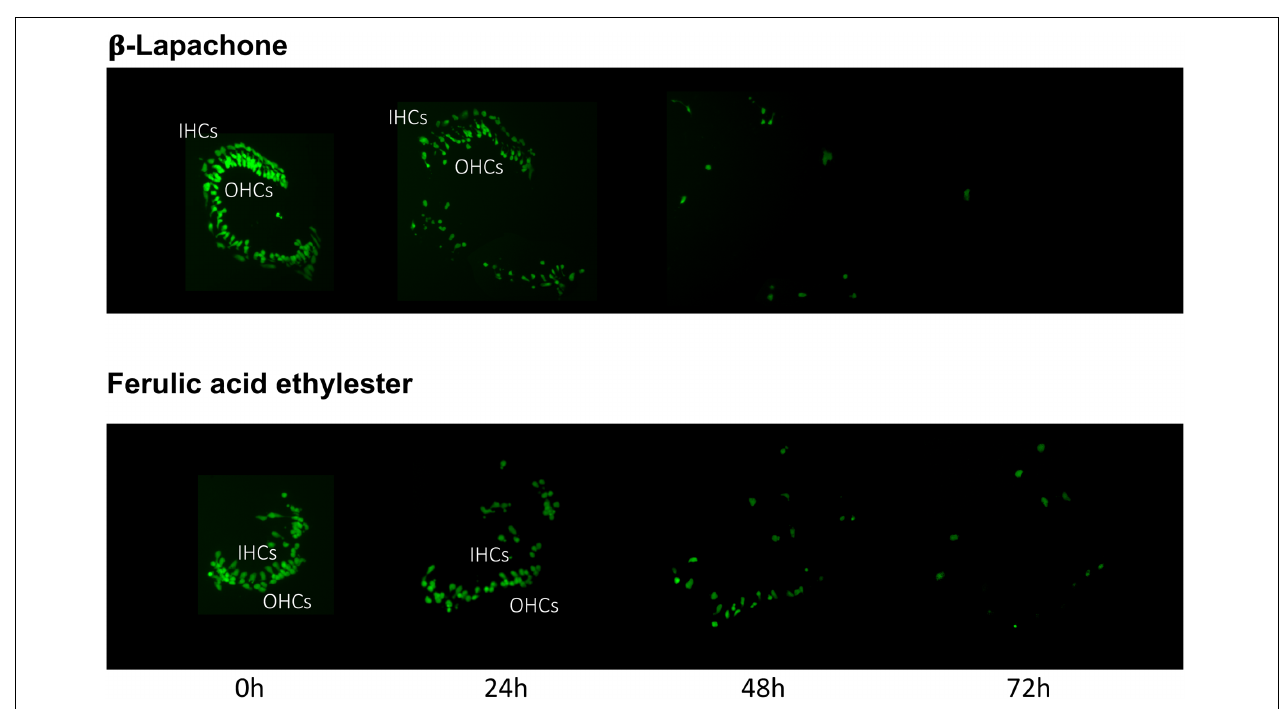
FIGURE 8 | Montages illustrating representative oC micro-explants treated with 1000 µ M β -lapachone alone, or 1000 µ M ferulic acid ethylester alone, for 72 h, illustrating HC toxicity without